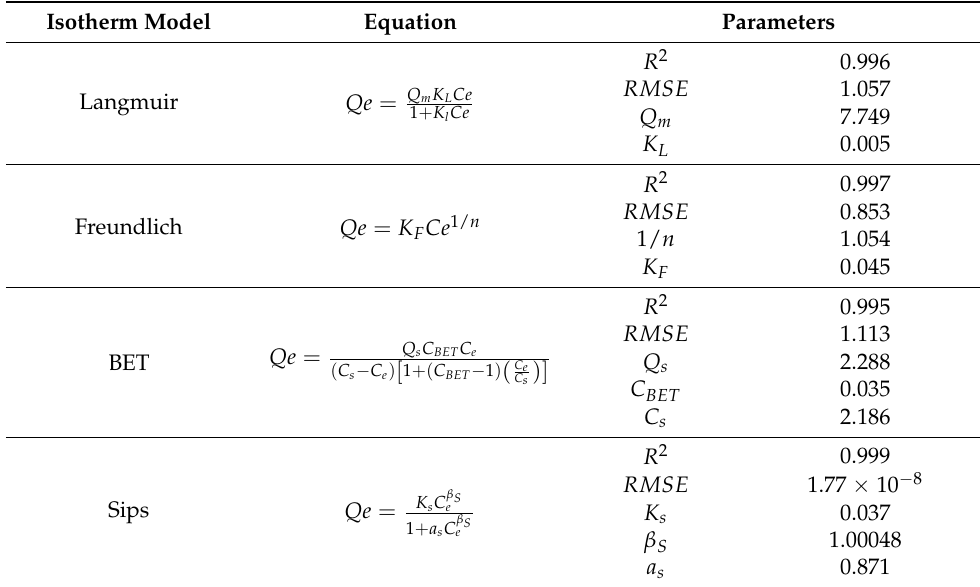
Table 1. Determined isothermal parameters obtained from various